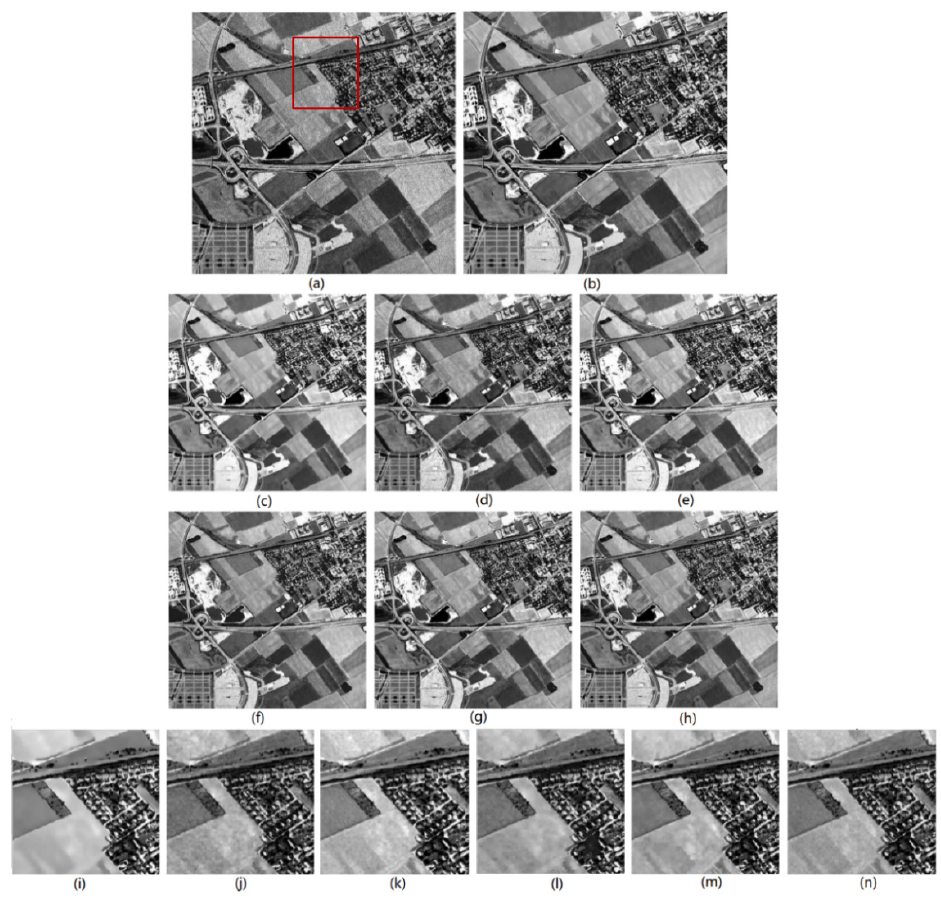
Figure 4. The despeckling result of the simulated SAR dataset. ( a ) Speckled image. ( b ) Clean image. ( c – h ) The PPB filter, the SAR-DRN filter, the BM-NR-DL filter trained with one image, the NR-SAR-DL filter, the MSAR-BM3D filter, and the BM-NR-DL filter trained with bi-temporal images, respectively. ( i – n ) Sub images of the highlight part in ( a ) and cropped from ( c – h ), respectively. Table 2. Quantitative assessment results for the simulated dataset.